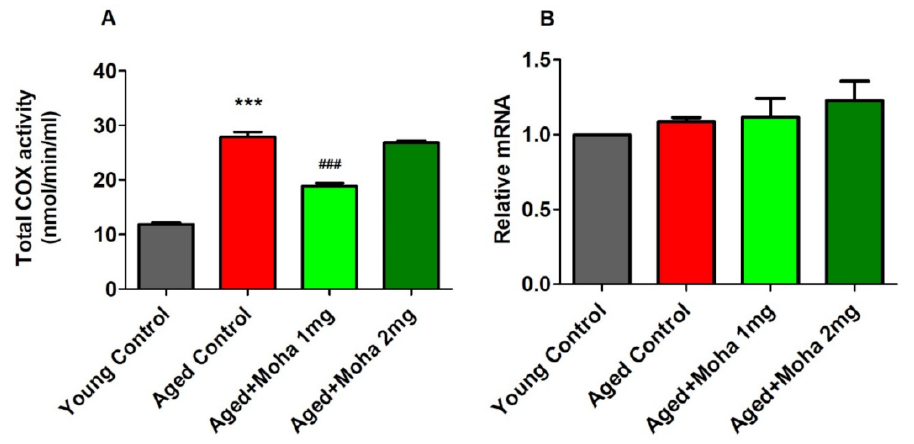
Figure 7. Effects of mahanimbine on COX activities in aged mouse brain. ( A ) Comparison of total COX activity. ( B ) Comparison of the expression of COX-2 gene. Mahanimbine administration ameliorated COX-2 activity in aged mouse brains. All data were expressed as mean ± SEM ( n = 6). One-way ANOVA ( F (3,20) = 78.20, p < 0.001 for total COX activity and F (3,20) = 1.096, p > 0.05 for expression of COX-2 gene) followed by Tukey–Kramer multiple comparisons test. *** p < 0.001 in comparison with young control; ### p < 0.001 in comparison with aged